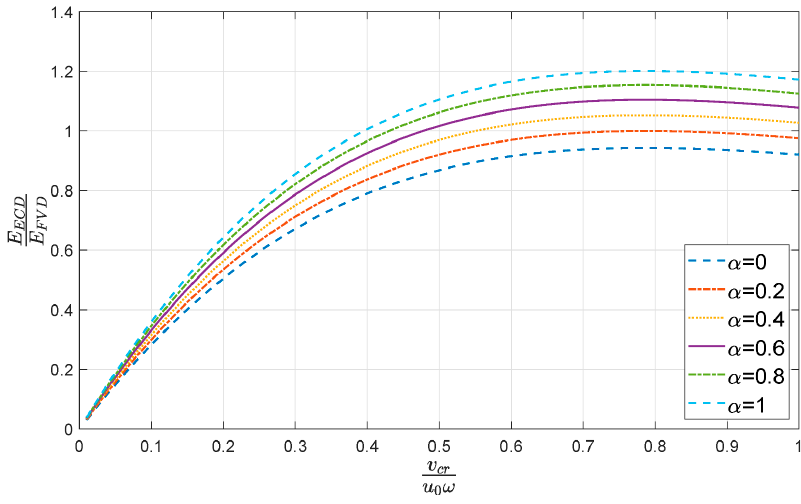
Figure 3. The energy dissipation ratio versus the velocity